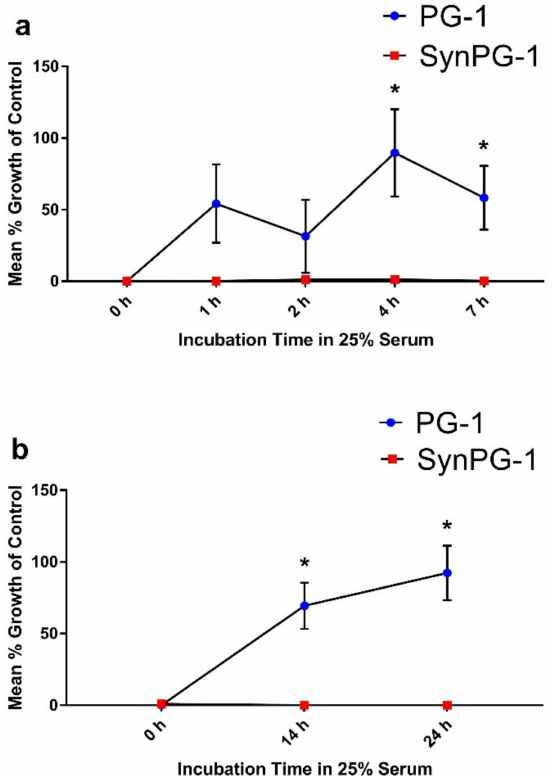
Figure 2. Serum stability of PG-1 and SynPG-1, represented by the mean % growth of control when tested against E. coli ( a ) after peptides were incubated for up to 7 h in 25% serum and ( b ) after peptides were incubated up to 24 h in 25% serum. All experiments were conducted three independent times. Peptides were both tested at a concentration 10 times their MBC (20 µ g / mL). Stability was evaluated by comparing the mean growth of colonies on plates treated with peptides incubated in serum to colonies grown when treated without peptide. Data represent the mean ± SEM of three experiments. The asterisk represents p < 0.05 when compared with SynPG-1 by two-way ANOVA with a post hoc Tukey